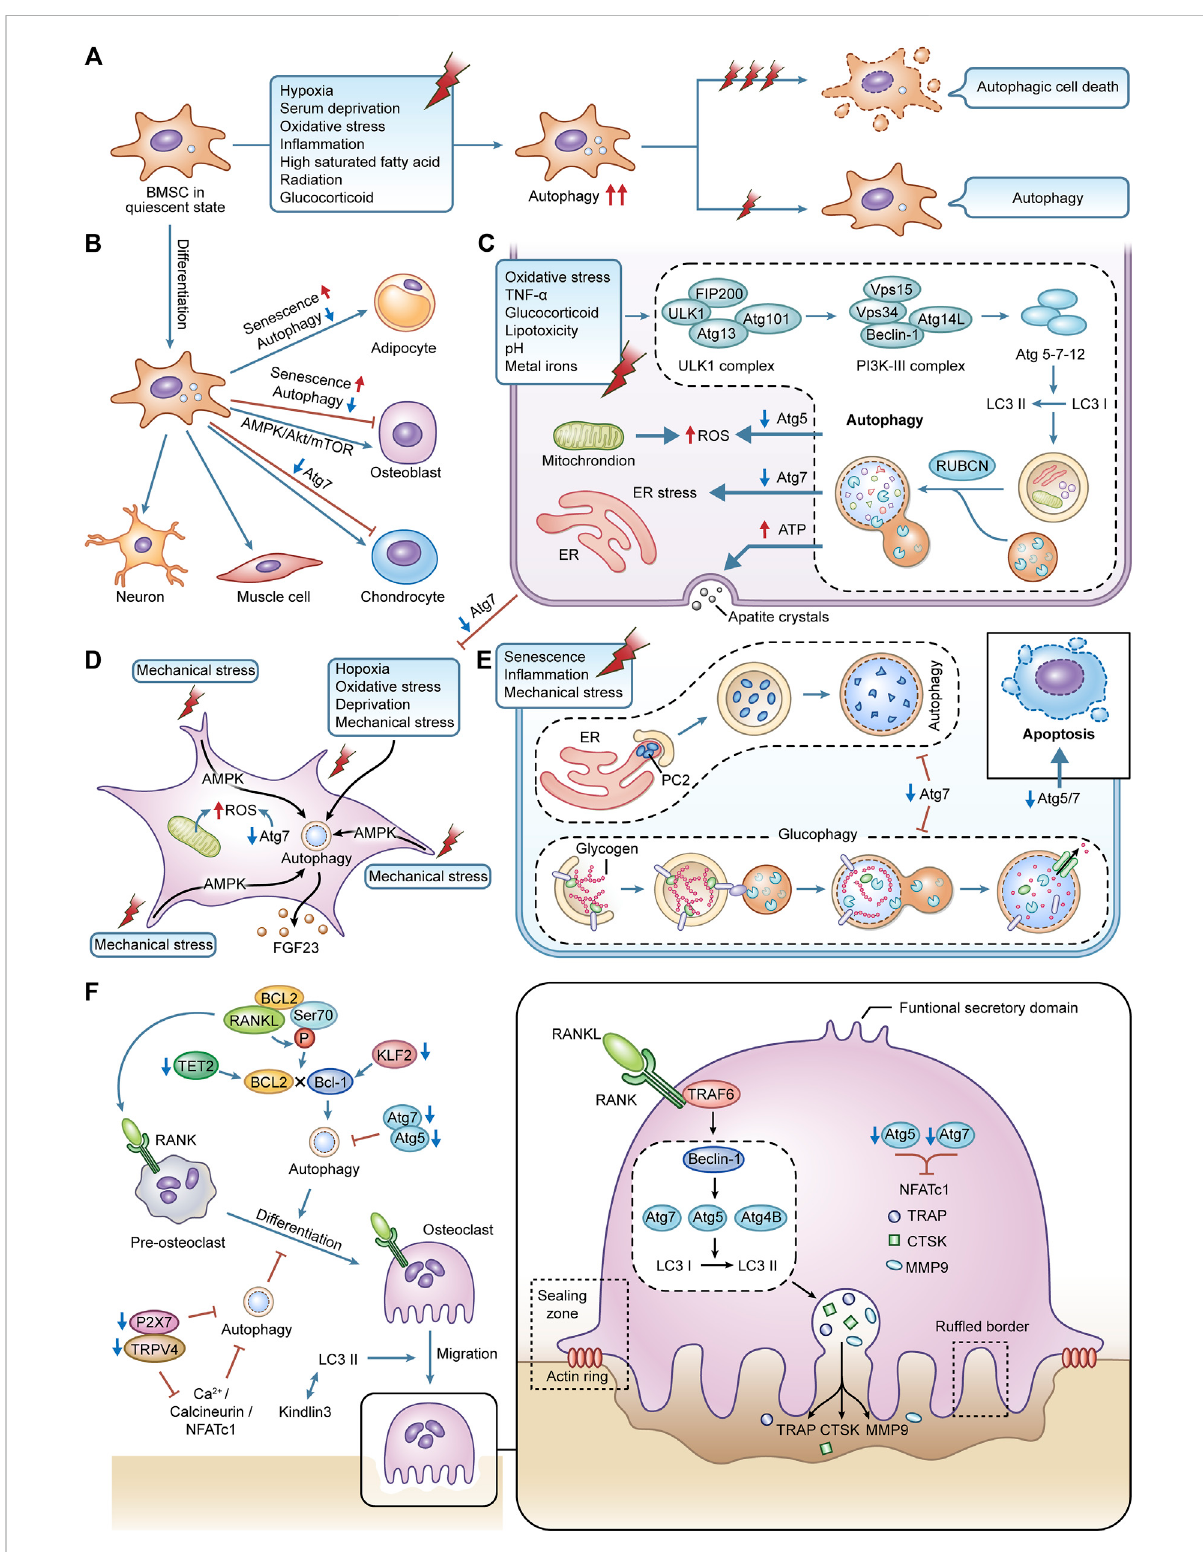
FIGURE 2 The effects of autophagy in various bone cell. (A) autophagy in BMSCs is activated during cellular differentiation, responding to external stress. (B) the specialized differentiation process in BMSCs is modi fi ed by autophagy. (C) autophagy in osteoblasts is activated caused by the stimulation